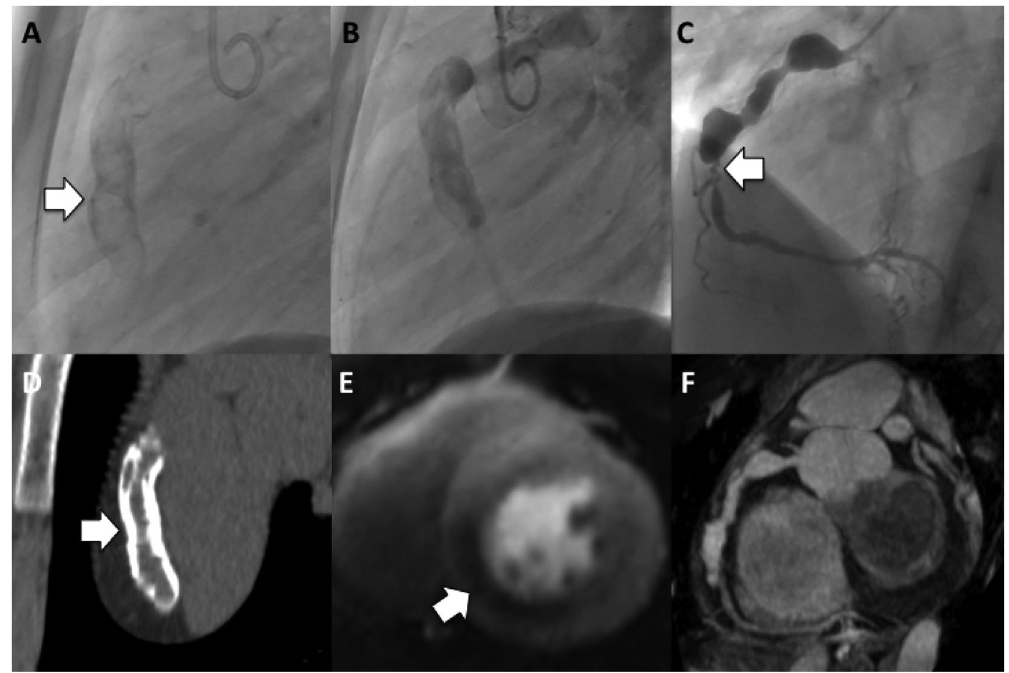
Figure 3. Stress perfusion CMR in right coronary artery stenosis. A,D) Calcific cast of RCA (arrow) is noted prior to contrast injection. B,C) Note that the contrast column does not touch the vessel edge outlined by the calcium, consistent with the presence of laminar thrombus. A focal tight mid RCA stenosis is present (arrow). E) Area of hypoperfusion (arrow) in the basal infero-septum on dipyridamole stress CMR. F) Whole heart coronary MRA of